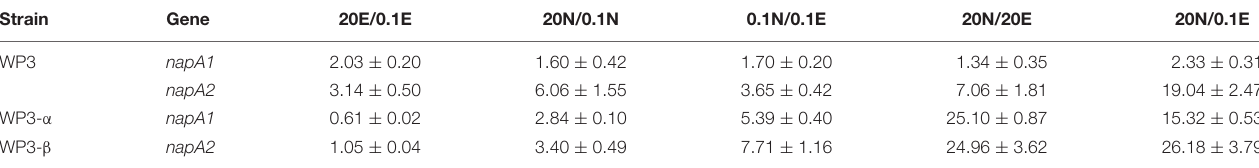
TABLE 2 | Transcriptional analyses of napA in WP3 and mutants under different conditions. Strain